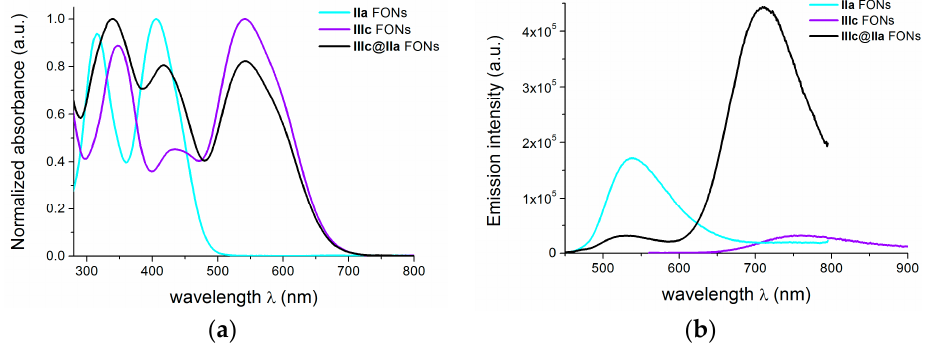
Figure 11. ( a ) Normalized absorption spectra of FONs IIa , IIIc and IIIc@IIa in water; ( b ) Emission spectra of FONs IIa ( λ exc = 406 nm), IIIc ( λ exc = 542 nm) and IIIc@IIa ( λ exc = 406 nm).